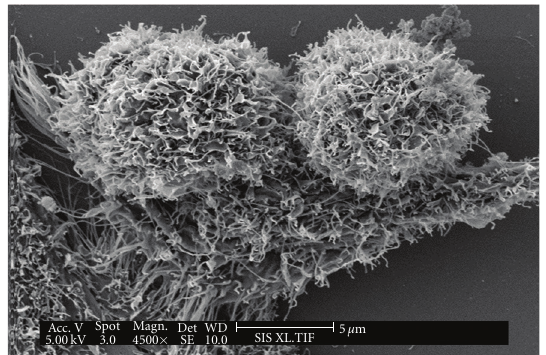
Figure 5: Scanning electron micrograph (SEM) of two normal HeLa cancer cells.